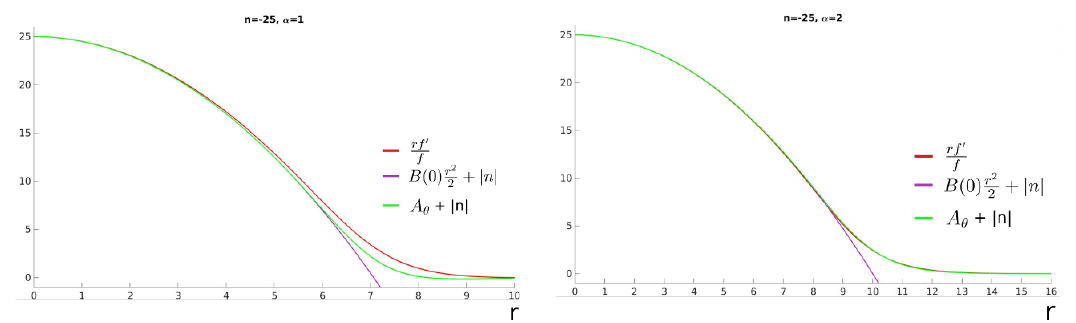
The (cid:12)gure shows the three